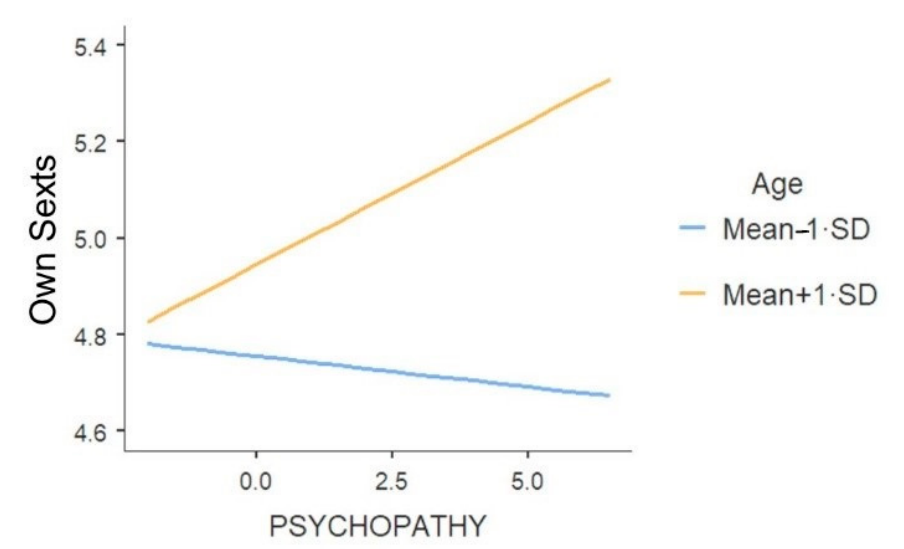
Figure 1. The effect of psychopathy on sharing own sexts in function of age. Table 7. Risky sexting: parameter estimates of fixed effects.